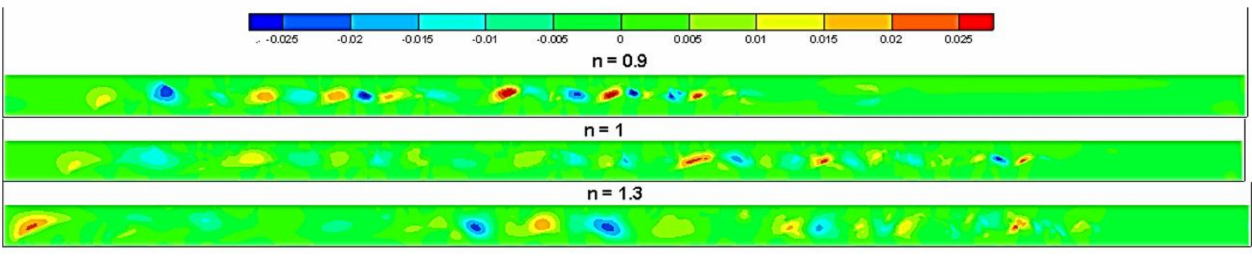
Figure 9. The transverse velocity of the mixture for different n.